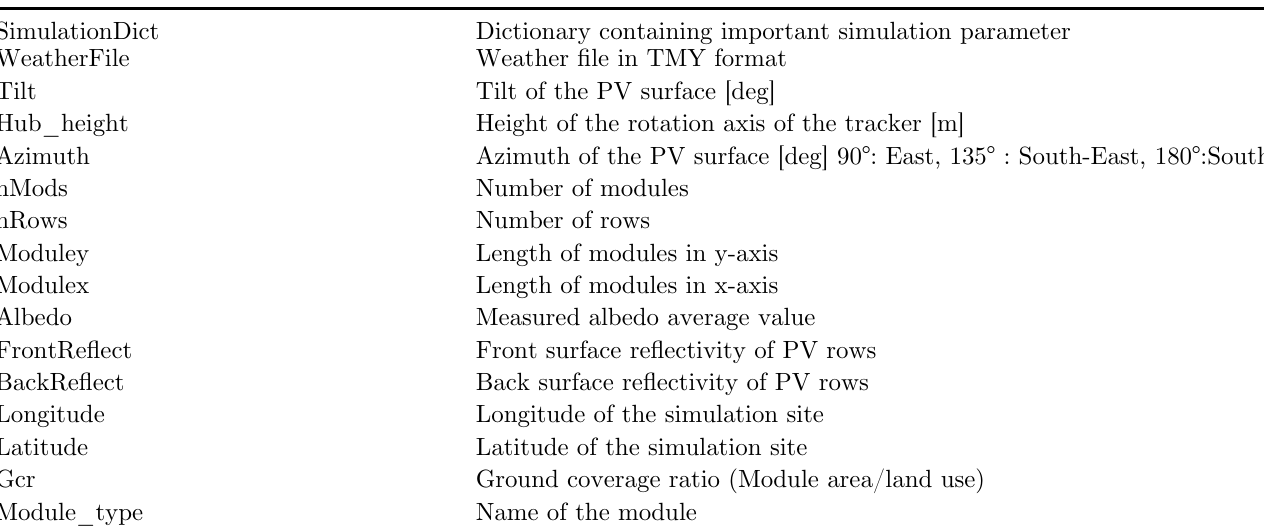
Table 2. Most of the relevant data concerning the bifacial PV simulation. Here, the user can de fi ne usual characteristics of PV power plants like number of rows and modules per row.